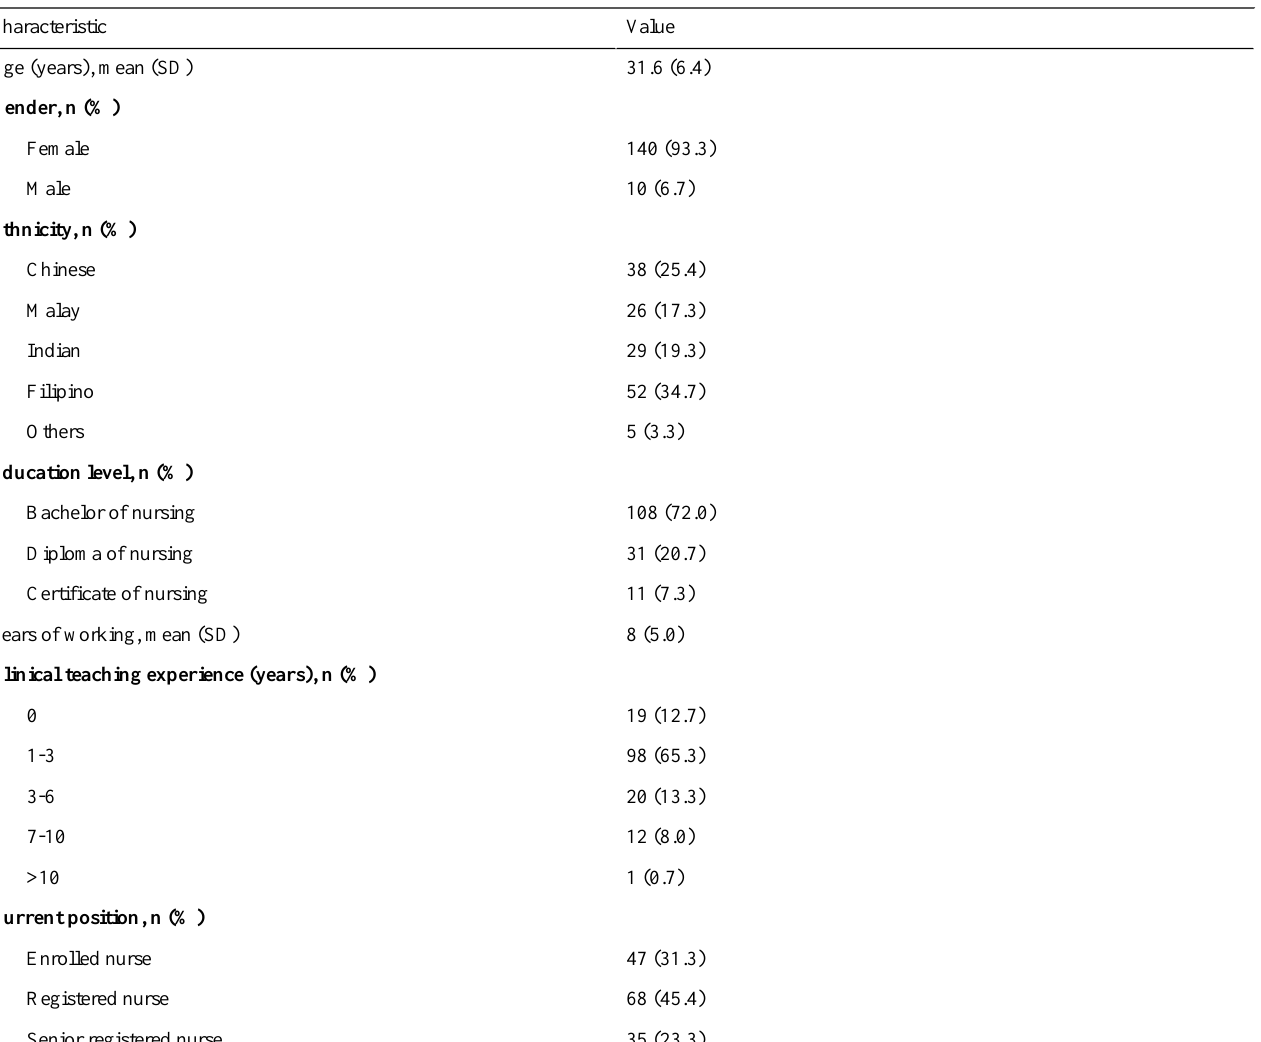
Table 2. Sociodemographic characteristics of the participants